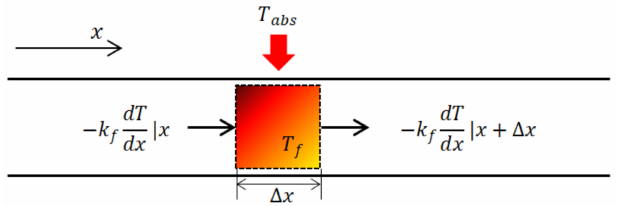
Figure 10. Analysis of thermal energy conservation in a microbody of salty